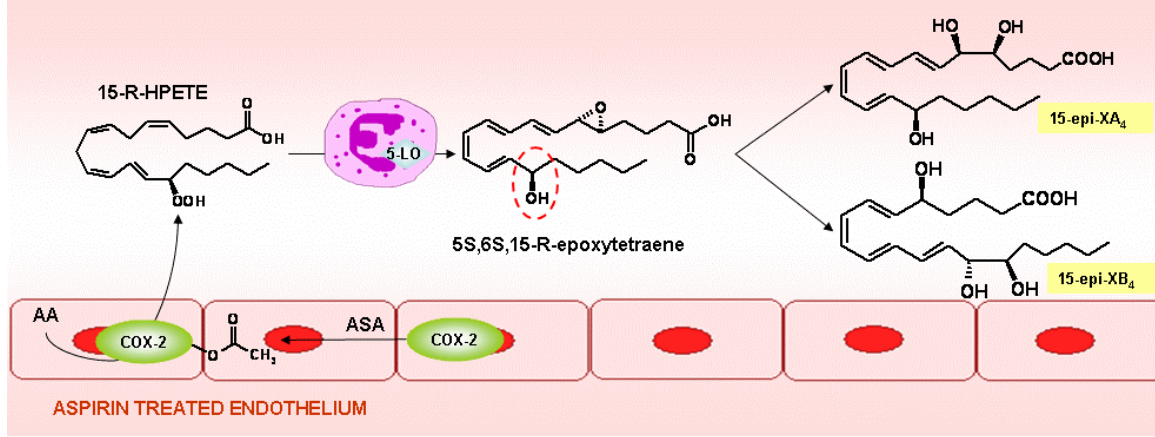
FIGURE 3 . Scheme of 15-epi-LXs biosynthesis (see text for